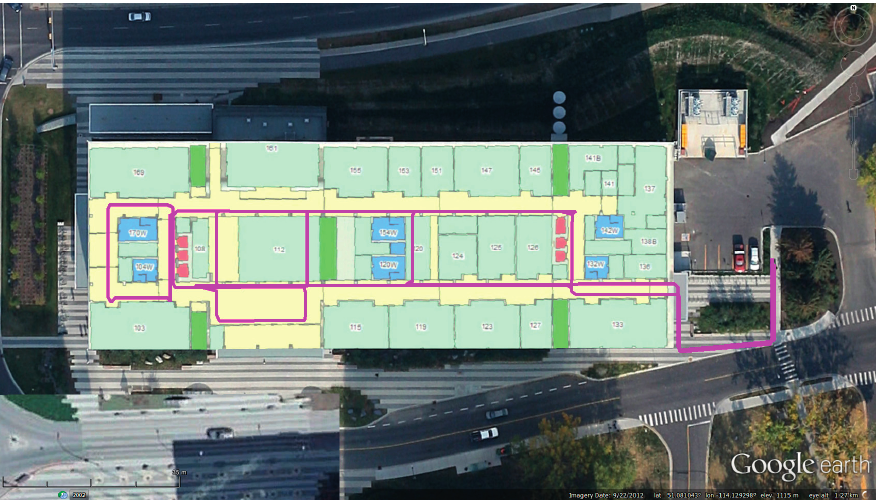
Figure 9. The trajectory used to test WiFi fingerprinting.